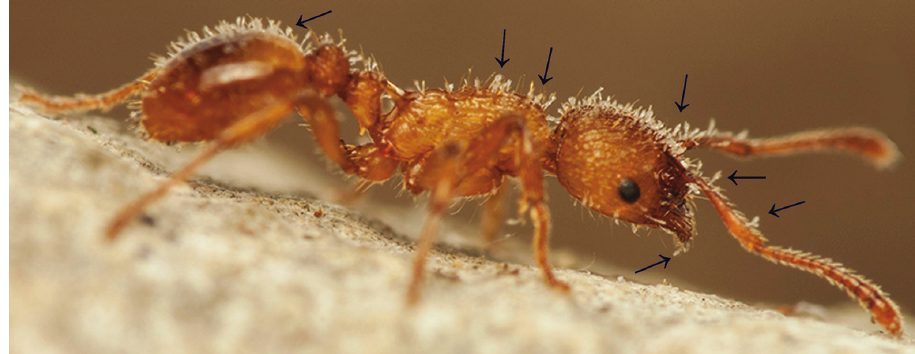
Figure 1. Myrmica scabrinodis worker with Rickia wasmannii thalli (arrows indicate some